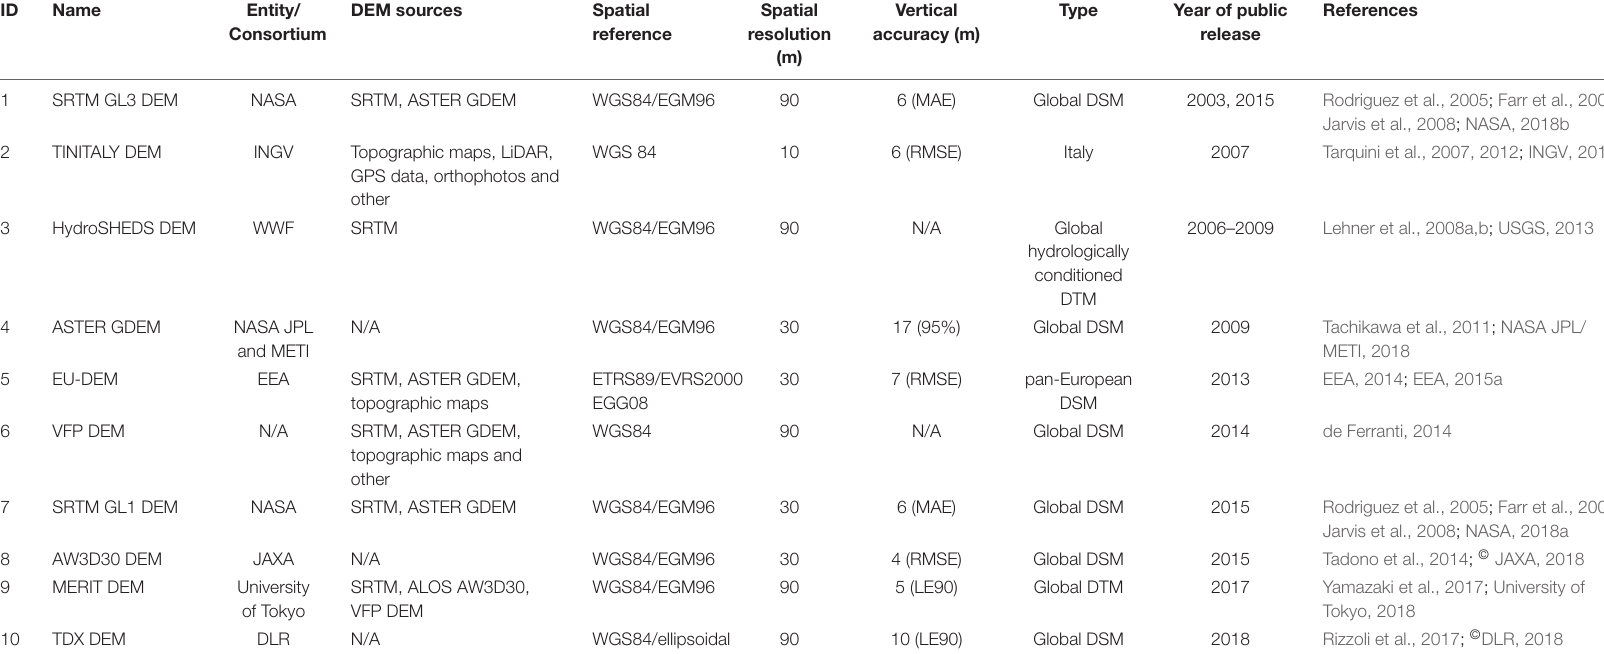
Datasets are used as provided, except for the coordinate systems that were transformed to WGS84/EDM96 when not already referred to this reference system and a transformation grid was easily